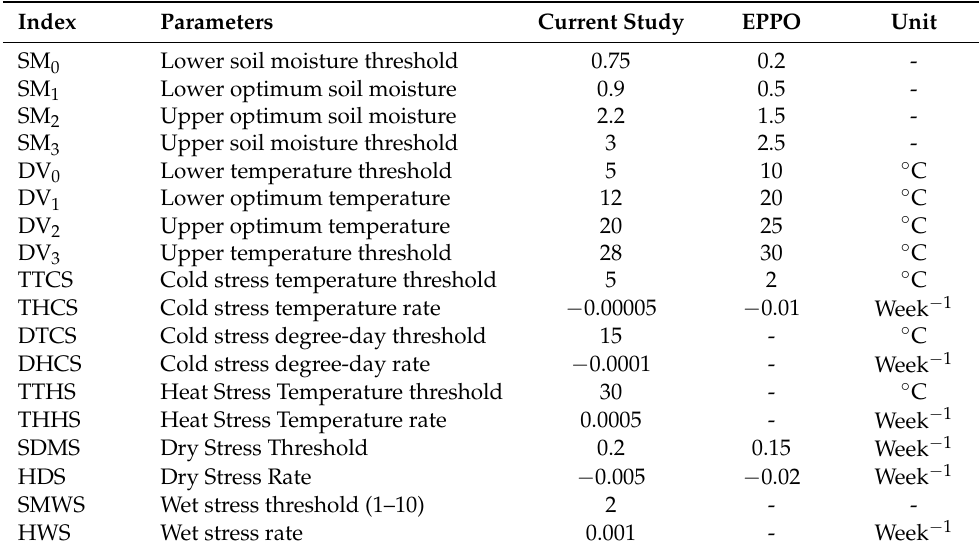
Table 1. Parameter values used in developing CLIMEX model for Psa in the current study. The table also shows the parameter values used by the CLIMEX model in the EPPO report